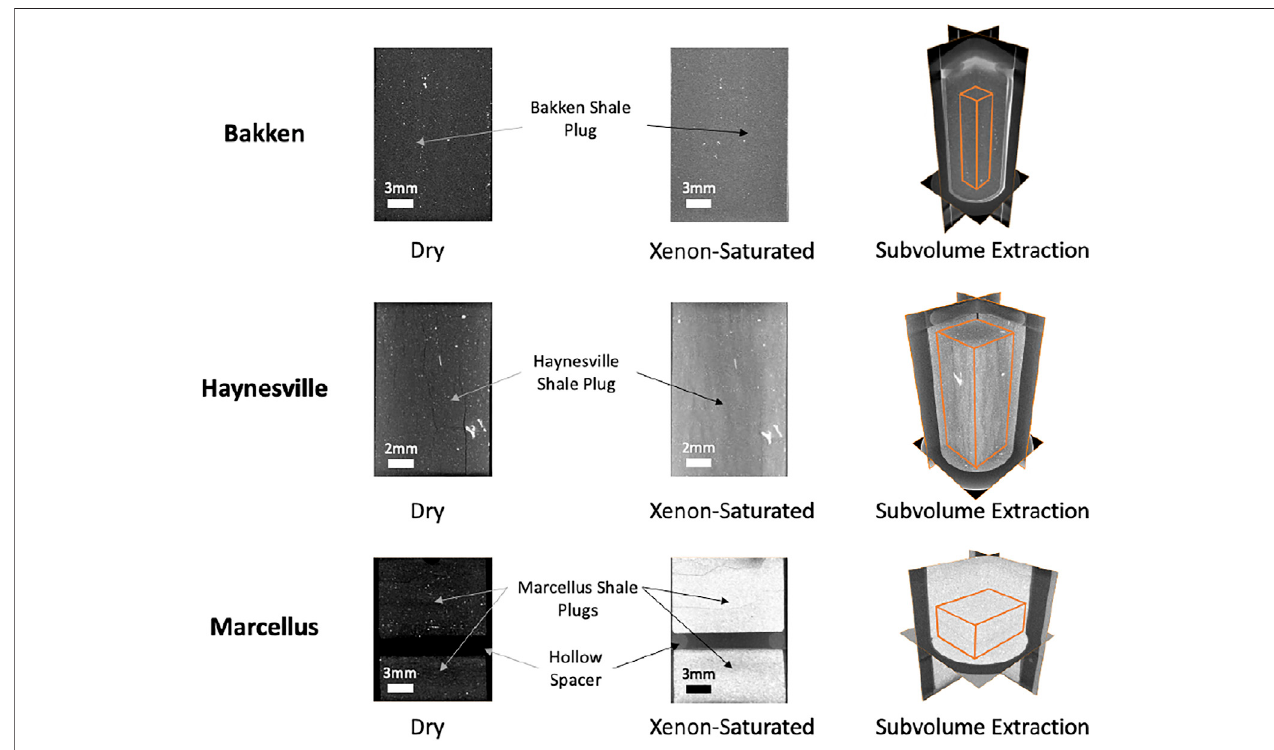
FIGURE 2 | CT images of the Bakken (Top), Haynesville (Middle) and Marcellus (Bottom) shale samples. Left to right: Two-dimensional longitudinal cross-sections of the shale sample at dry conditions (before xenon injection); same cross-section at equilibrium conditions; and the indication of digitally extracted sub-volumes for further